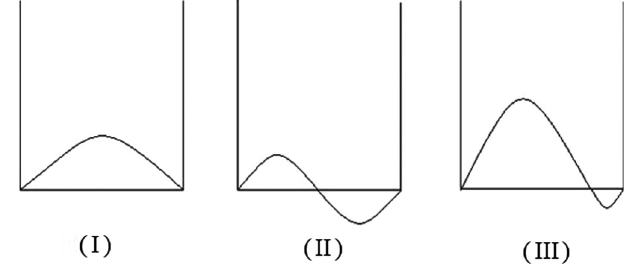
FIG. 1. Pictorial question in the warm up testing students’ understanding of the energy eigenstates for a 1D infinite square well. (I) and (II) are energy eigenstates but their superposition (III) is